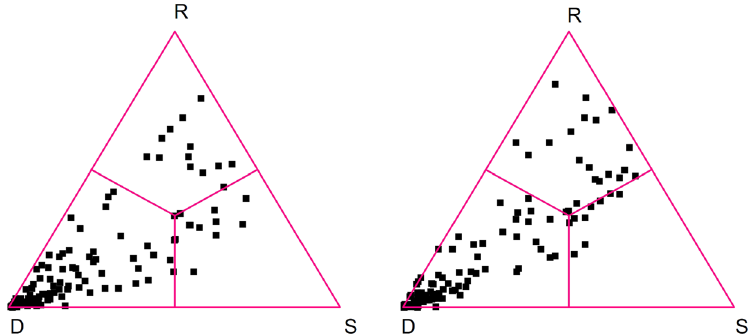
Figure 5. Simplex plots based on Similarity (S), Richness Difference (D) and Species Replacement (R) for all the pairwise comparisons (n = 120) of the 16 islands of the Tuscan archipelago in the 1830-1950 (left) and 1951–2015 (right) periods,